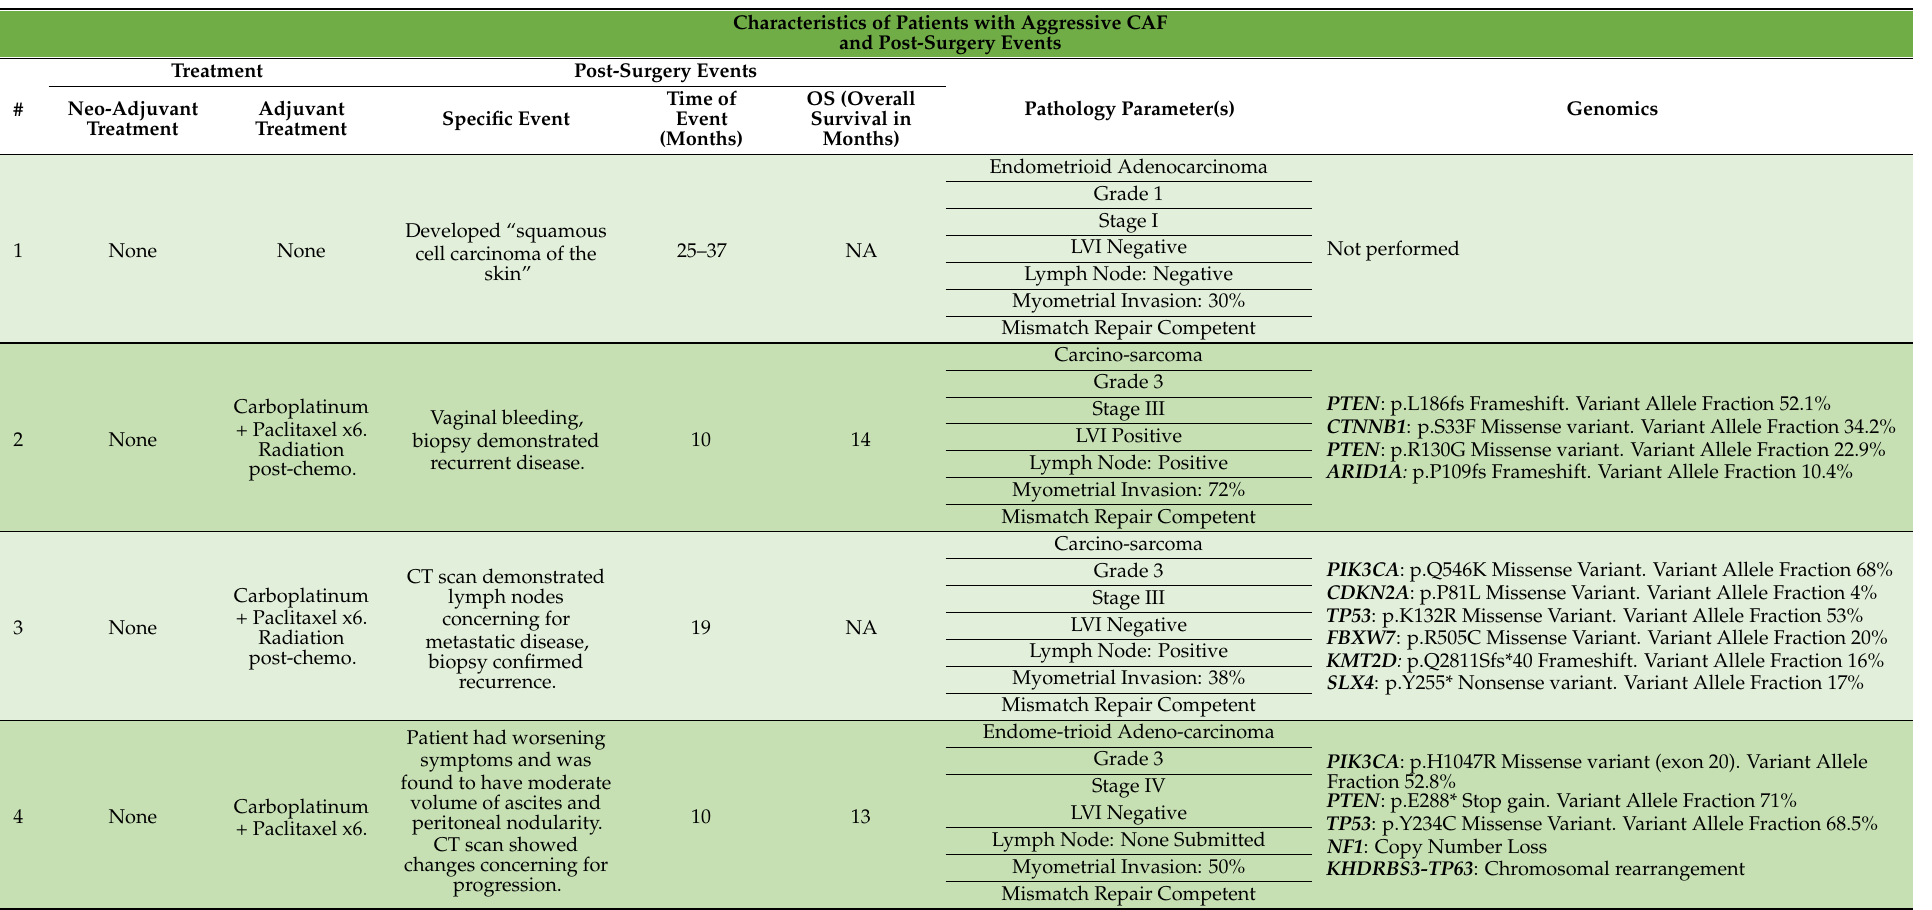
Table 3. Pathological parameters, genomic alterations, and treatment details of endometrial cancer patients bearing aggressive CAFs who presented with a post-surgery